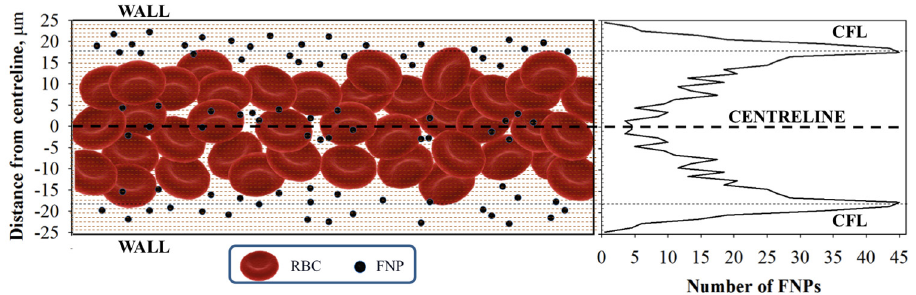
Figure 4. Cartoon of FNP flow and radial distribution in the presence of RBC flow inside the microcapillary.